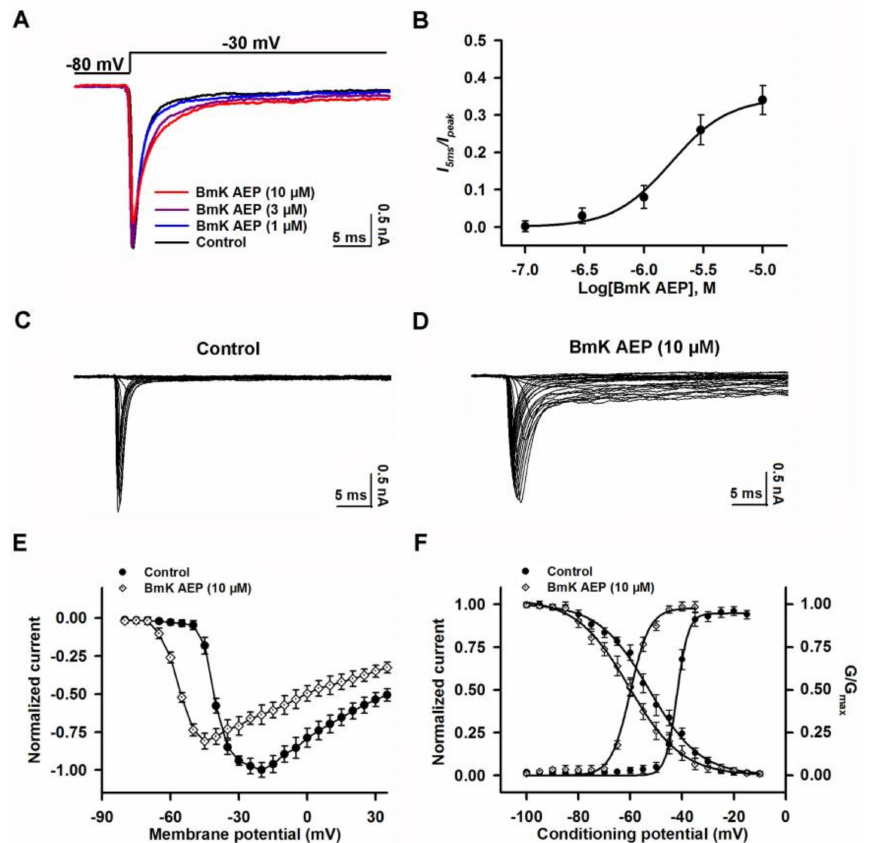
Figure 4. Influence of BmK AEP on hNa v 1.2 expressed in HEK-293 cells. ( A ) BmK AEP delayed Na v 1.2 channel inactivation. Na v 1.2 currents were triggered by a 50-ms depolarization to − 30 mV from a holding potential of − 80 mV. ( B ) Concentration–response relationship of BmK AEP-delayed inactivation of Na v 1.2 channels. ( C , D ) Representative traces of Nav1.2 currents in the absence and presence of 10 µ M BmK AEP, respectively. Currents were triggered by 50-ms depolarizations from − 100 to 30 mV in a 5-mV step. ( E ) Normalized I–V relationships of Na v 1.2 currents in the absence and presence of 10 µ M BmK AEP. ( F ) Effect of BmK AEP (10 µ M) on the steady-state activation and inactivation of Nav1.2. Each data point represents the mean ± SEM ( n = 5–8). 2.5. Influence of BmK AEP on hNa v 1.3 Stably Expressed in HEK-293